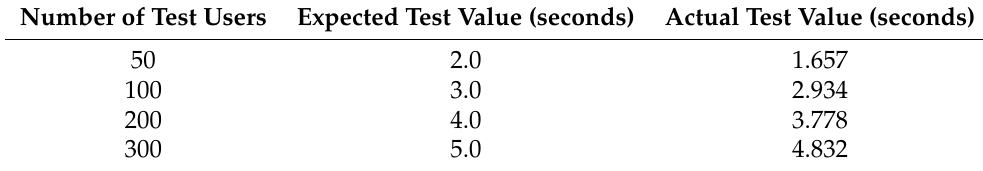
Table 6. Concurrent user performance test